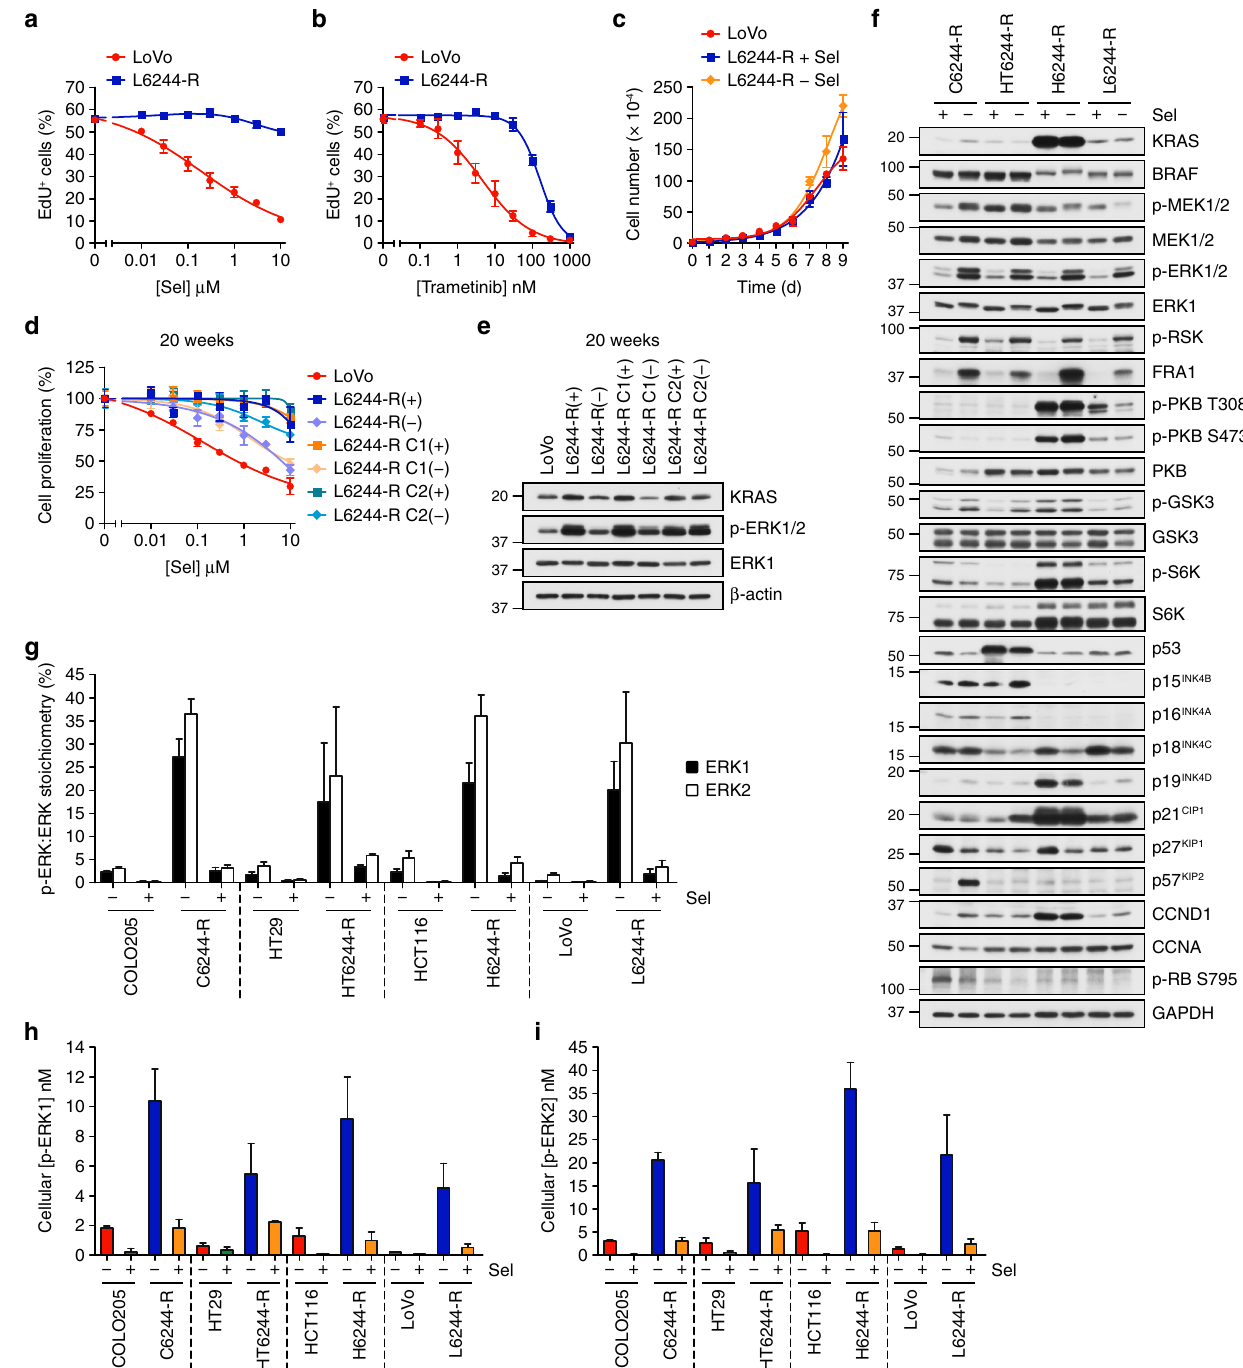
Fig. 7 MEKi withdrawal from BRAF V600E - or KRAS G13D -ampli fi ed cells causes equivalent ERK1/2 hyperactivation. a , b LoVo and L6244-R cells were treated with the indicated concentrations of selumetinib (Sel) ( a ) or trametinib ( b ) for 72h. Percent EdU-positive (EdU + ) cells was determined by high-content image analysis. Results are normalized to LoVo control. c LoVo and L6244-R cells plated in their normal growth medium were treated with either 4 μ M selumetinib (L6244-R + Sel) or DMSO only (LoVo, L6244-R − Sel) and cell numbers counted over 9 days. Results are mean±SD of cell culture triplicates, representative of two experiments. d , e Following 20 weeks culture in the presence ( + ) or absence (LoVo, ( − )) of 4 μ M selumetinib, cells were treated with the indicated concentrations (10nM to 10 μ M) of selumetinib (Sel) for 24h, and DNA synthesis assayed by [ 3 H]thymidine incorporation ( d ), or incubated in selumetinib-free medium for 24h and lysates western blotted with the indicated antibodies ( e ). Results ( d ) are mean±SD of cell culture triplicates and normalized to control for each cell line. f C6244-R, HT644-R, H6244-R and L6244-R cells were treated with 1, 1, 2 and 4 µ M selumetinib (Sel, ( + )), respectively, or with DMSO only ( − ), for 72h. Lysates were western blotted with the indicated antibodies. Results are representative of at least two experiments giving equivalent results. g – i COLO205/C6244-R, HT29/HT6244-R, HCT116/H6244-R and LoVo/L6244-R cells were treated with 1, 1, 2, 4 µ M selumetinib (Sel), respectively, or with DMSO only ( − ) for 72h. Lysates were then subjected to SDS-PAGE and gel bands containing ERK1 and ERK2 removed for absolute quanti fi cation of dual- phosphorylated and total ERK1 and ERK2 peptides by mass spectrometry. Results are p-ERK/ERK stoichiometry (%) ( g ) or cellular concentrations of p-ERK calculated using cell volume measurements ( h , i ). Results ( a , b , g – i) are mean±SD of three independent